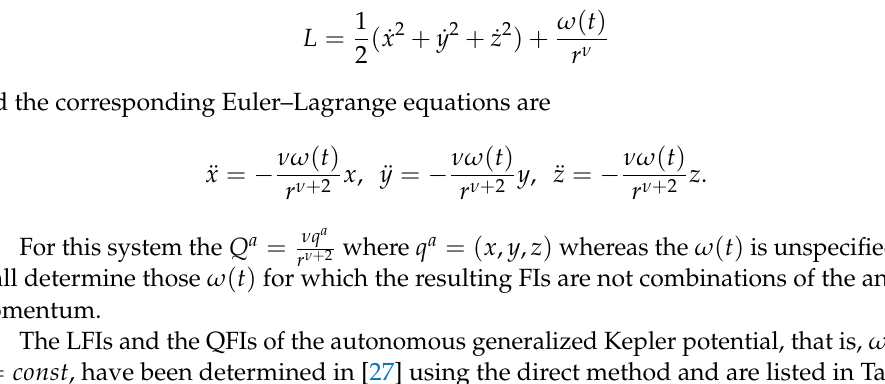
Table 1. The LFIs/QFIs of the autonomous generalized Kepler potential for ω ( t ) = k = const . V = − k r ν